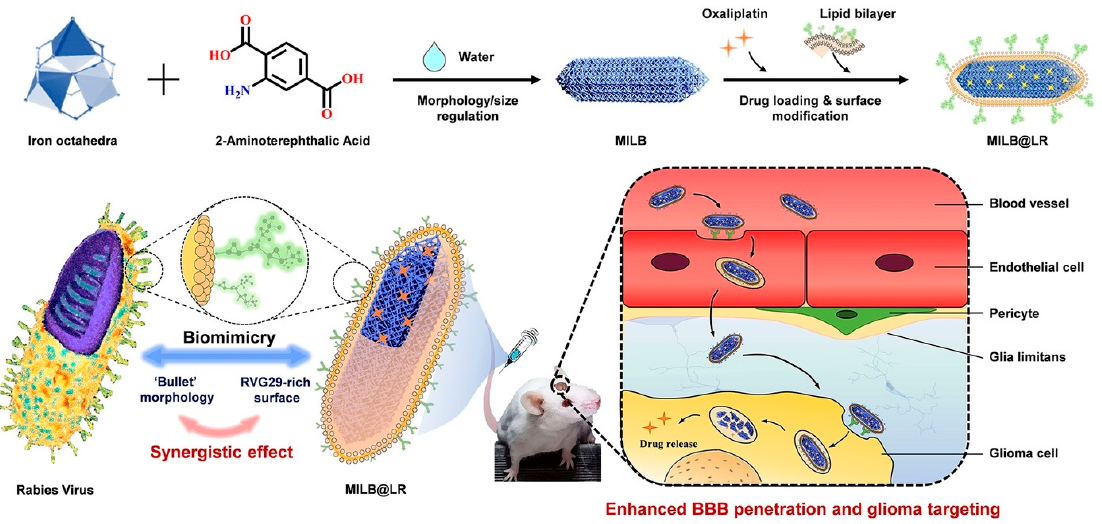
Figure 2. Manufacture of MILB@LR and a comprehensive simulation strategy on RABV to enhance BBB infiltration and chemotherapy for glioma. Reprinted with permission from [54]. Copyright 2020 John Wiley and